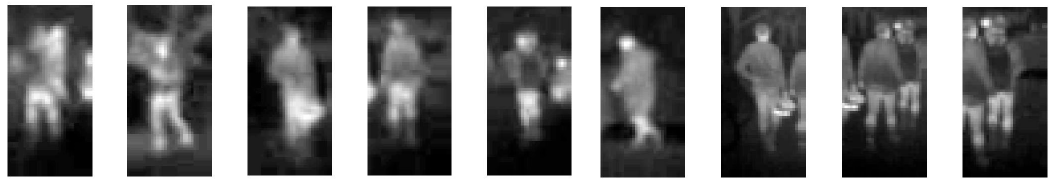
Figure 7. Examples of pedestrian IR images in KAIST pedestrian dataset [33].